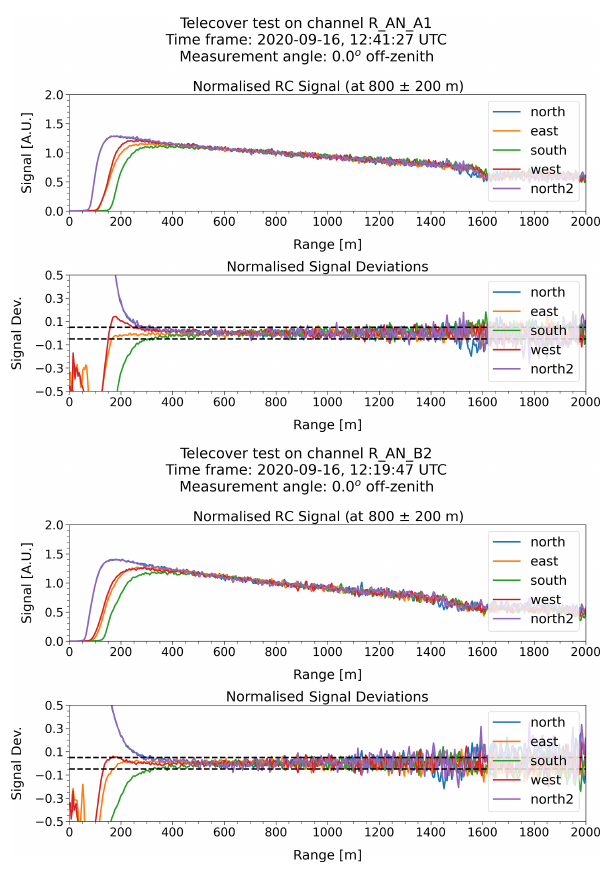
Figure B2. The octant telecover test using the telecover signals from the Reflected ( R ) channels of the A1 and B2 configurations on 16 September 2020. The signals are unsmoothed range-corrected analogue signals normalised at 800m with a window of 400m where the north (blue), east (orange), west (red), south (green), north2 (purple) indicate the measured telecover sector. The pro- vided signal deviation is the relative deviation of the normalised signal from the